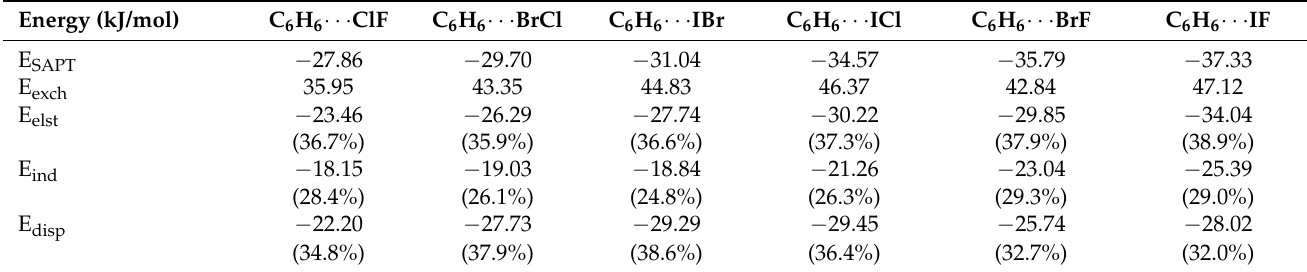
Table 3. The calculation analysis using symmetry matching perturbation theory